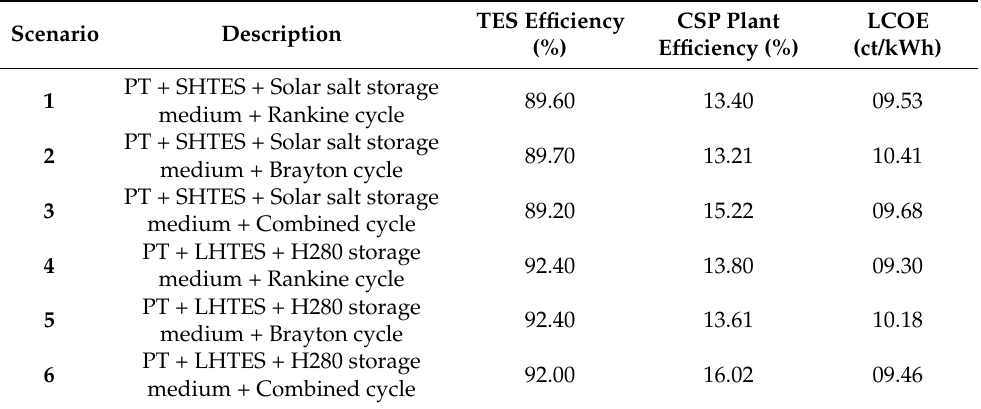
Table 11. LCOE analysis for a parabolic trough plant of 50 MW installed capacity with regular storage medium.